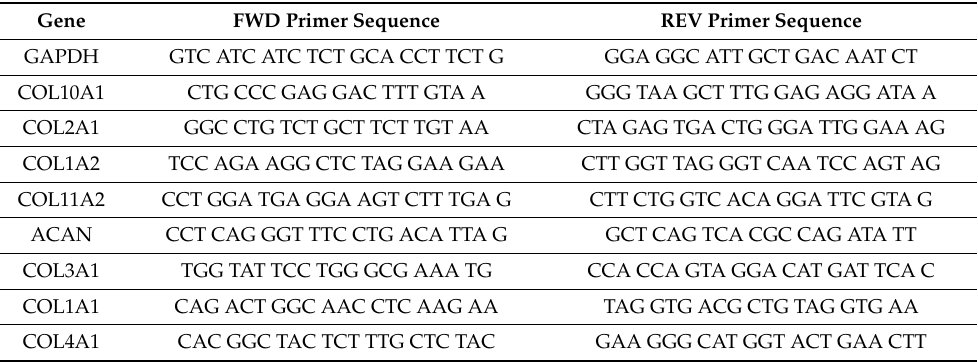
Table 1. qPCR Primer Sequences for cartilage and synovium markers. ACAN: Aggrecan, COL1: collagen type I, COL2: collagen type II, COL3: collagen type III, COL4: collagen type IV, COL5: collagen type V, COL10: collagen type X, COL11: collagen type XI, GAPDH (housekeeping gene).